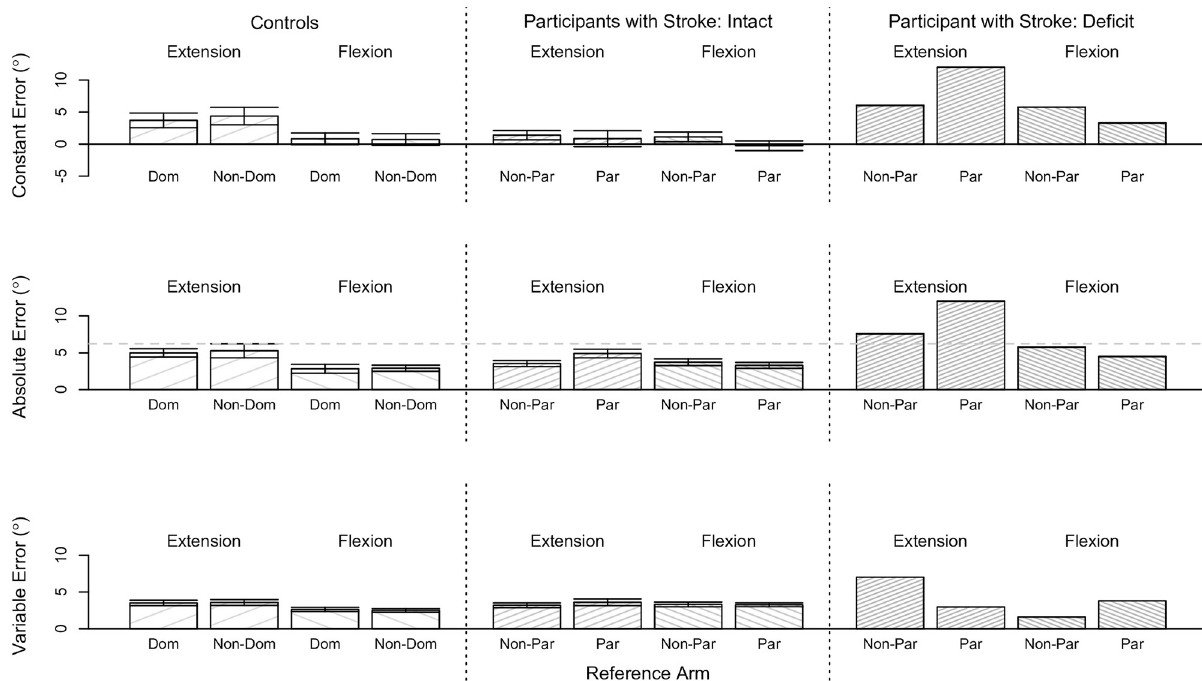
Fig 3. Single-arm position-matching results across all tested conditions. Shown are the robotic assessment results on the single-arm position- matching task for the controls and participants with stroke. Mean (bar height) and standard error (error bars) of the (Top) constant error, (Middle) absolute error, and (Bottom) variable error are given as a function of the reference arm and reference target location for each classified group of participants. The gray dashed horizontal line indicates the deficit threshold of 10.7˚. No significant effects were found. (Dom: dominant, Non-Dom: non-dominant, Non-Par: non-paretic, Par: